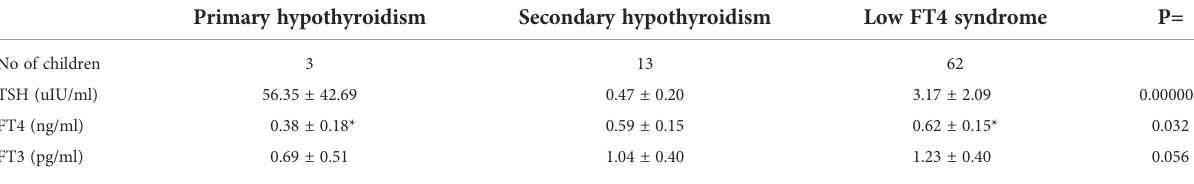
TABLE 1 Mean (± SD) values of TSH, FT4 and FT3 concentrations in newborns with hypothyroxinemia in individual subgroups, according to TSH values